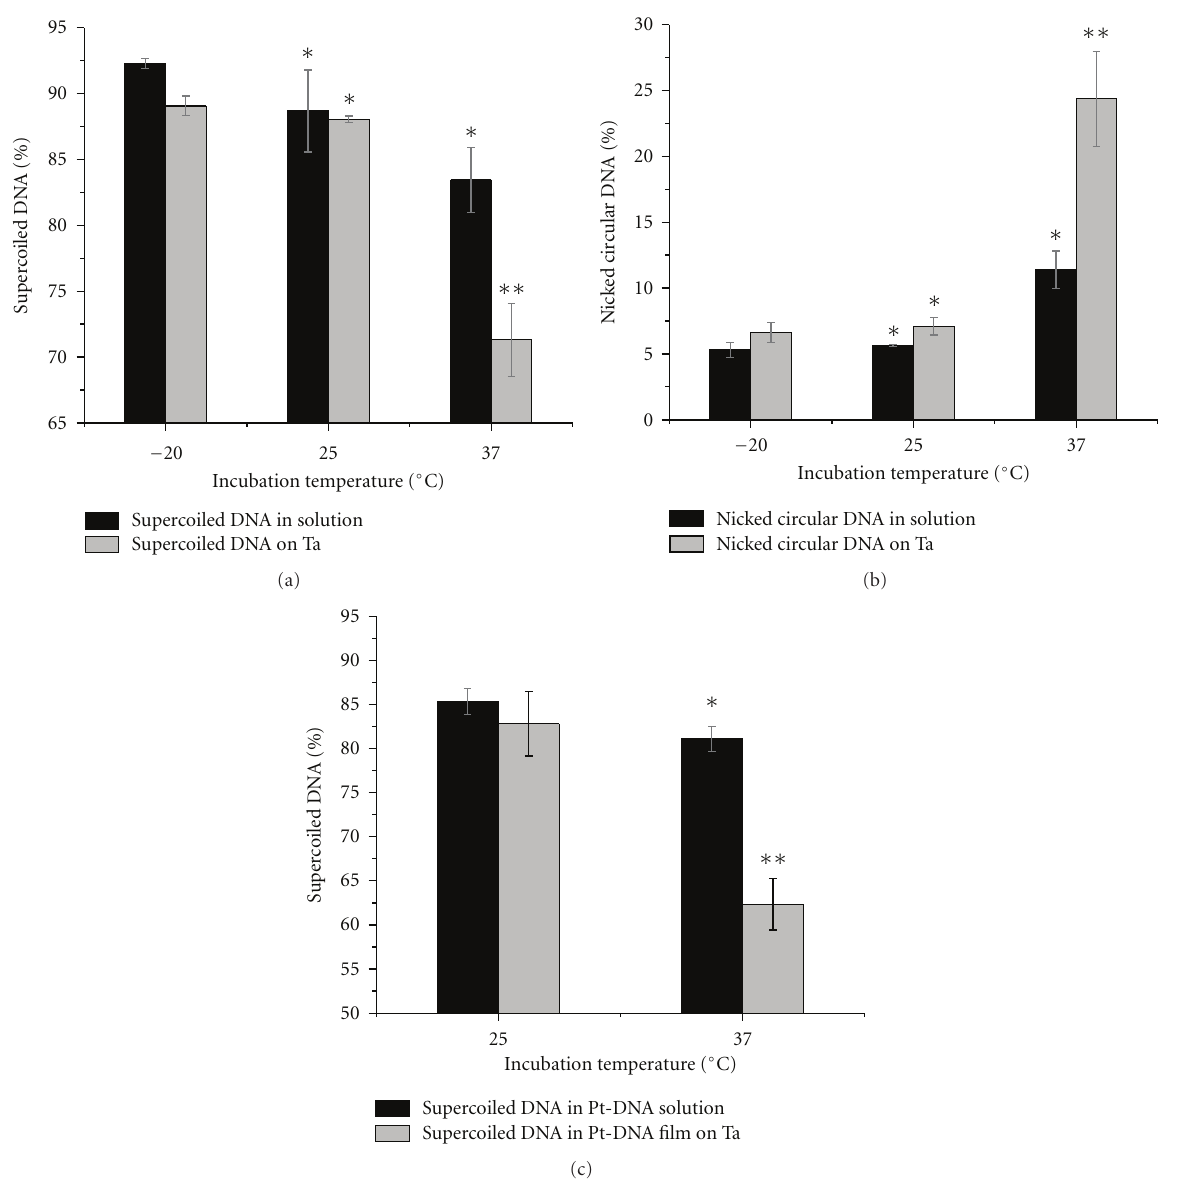
Figure 1: Comparison of the percentages of DNA supercoiled (a), DNA nicked circular (b), and Pt-DNA supercoiled (c) forms in the solution and film samples after incubation at − 20 ◦ C, 25 ◦ C, and 37 ◦ C for 24 hours. Data in (a)–(c) are means from three independent experiments; three samples at each temperature are analyzed in each experiment; error bars show standard deviations. ∗ indicates P value > 0.05, ∗∗ indicates P value <